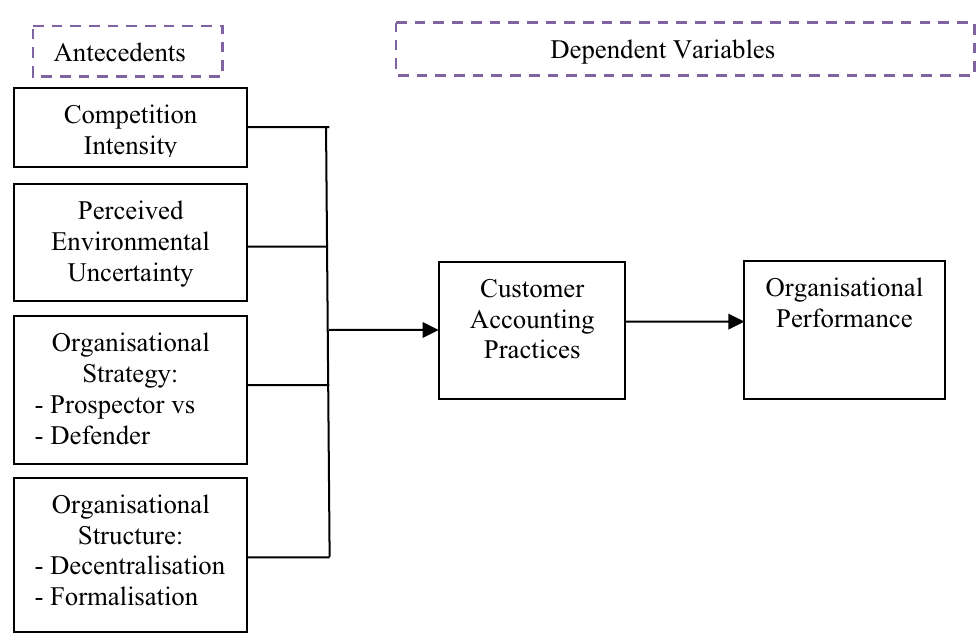
Fig. 1 The conceptual framework for this